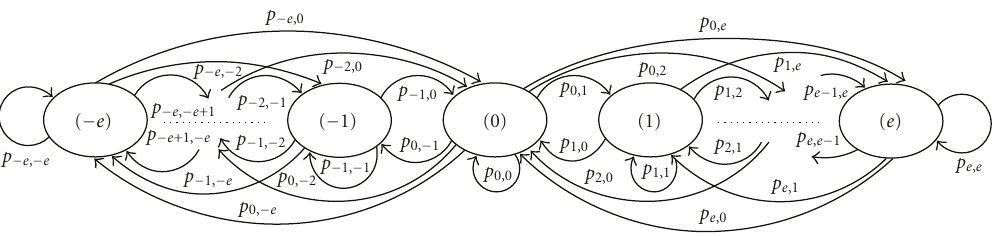
Figure 9: State transition diagram for the Markov chains representing movement in the GIMM model (for both x - and y -directions).